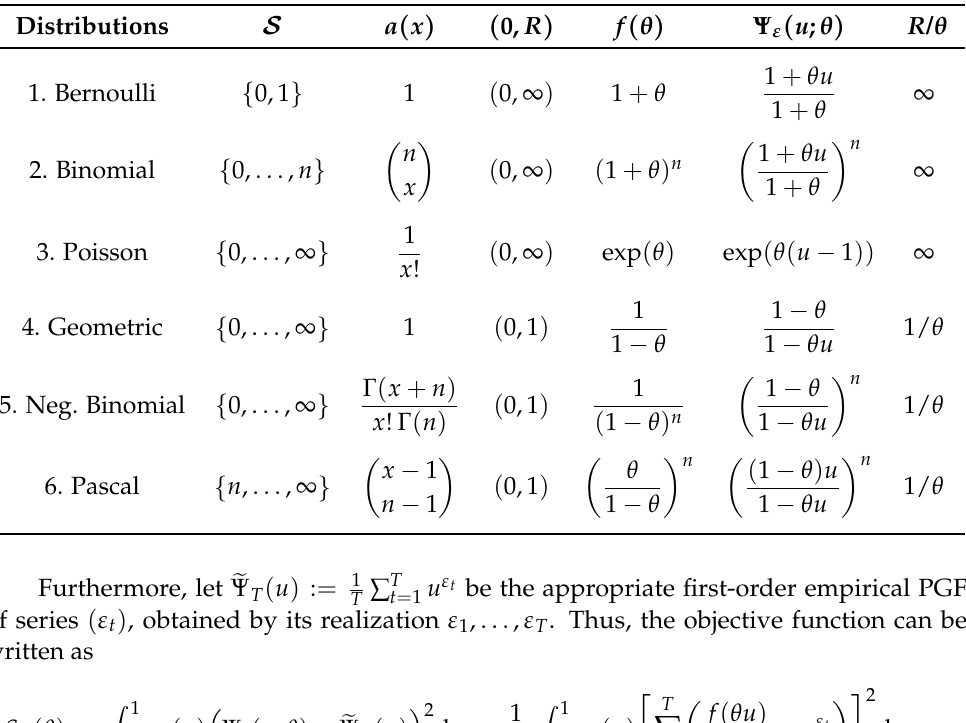
Table 1. NNIV distributions, along with their PGFs, interpreted in the form of PS distributions.